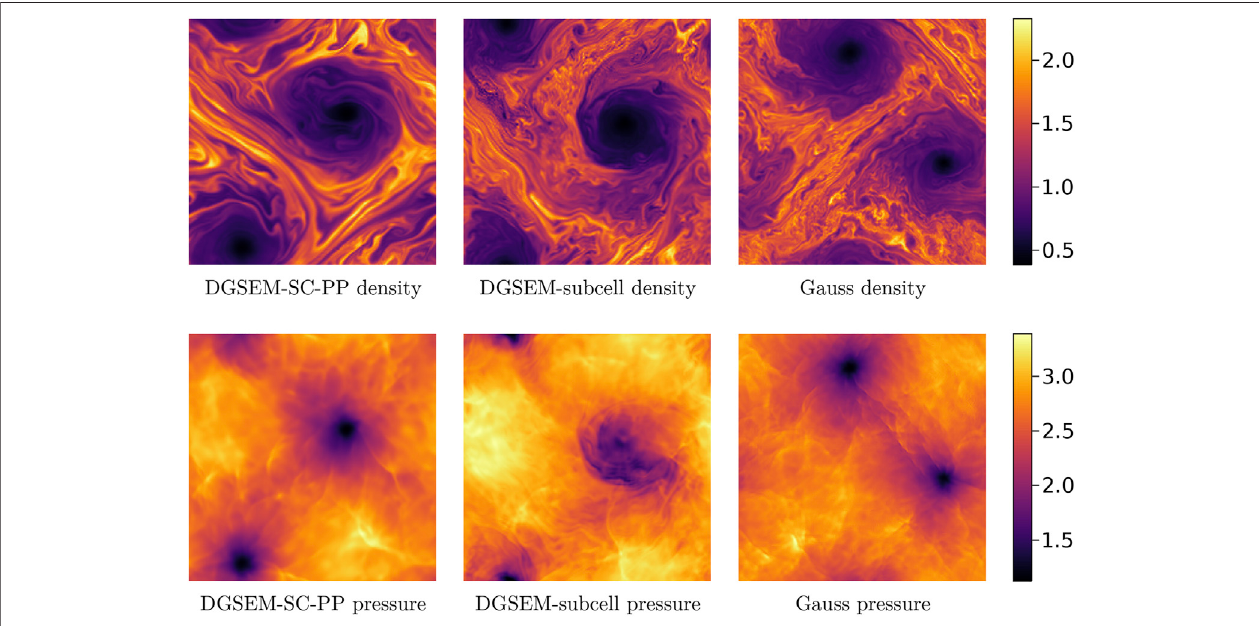
FIGURE 10 | Density and pressure for the Kelvin-Helmholtz instability at T fi nal = 25 on a N = 3 mesh of 64 2 elements.